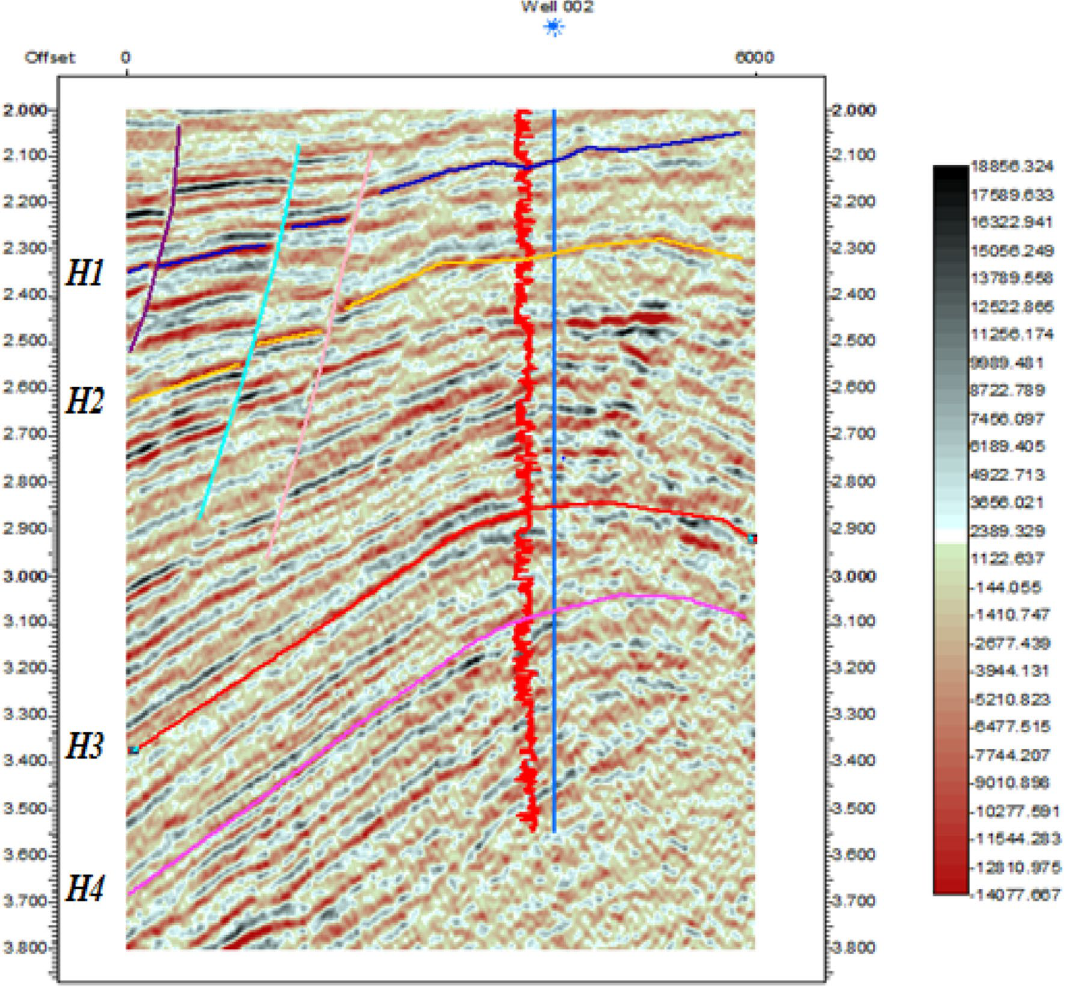
Fig. 5 Seismic volume showing picked horizon. The figure shows the seismic inline section with the inserted well log signature, four picked horizons and some fault